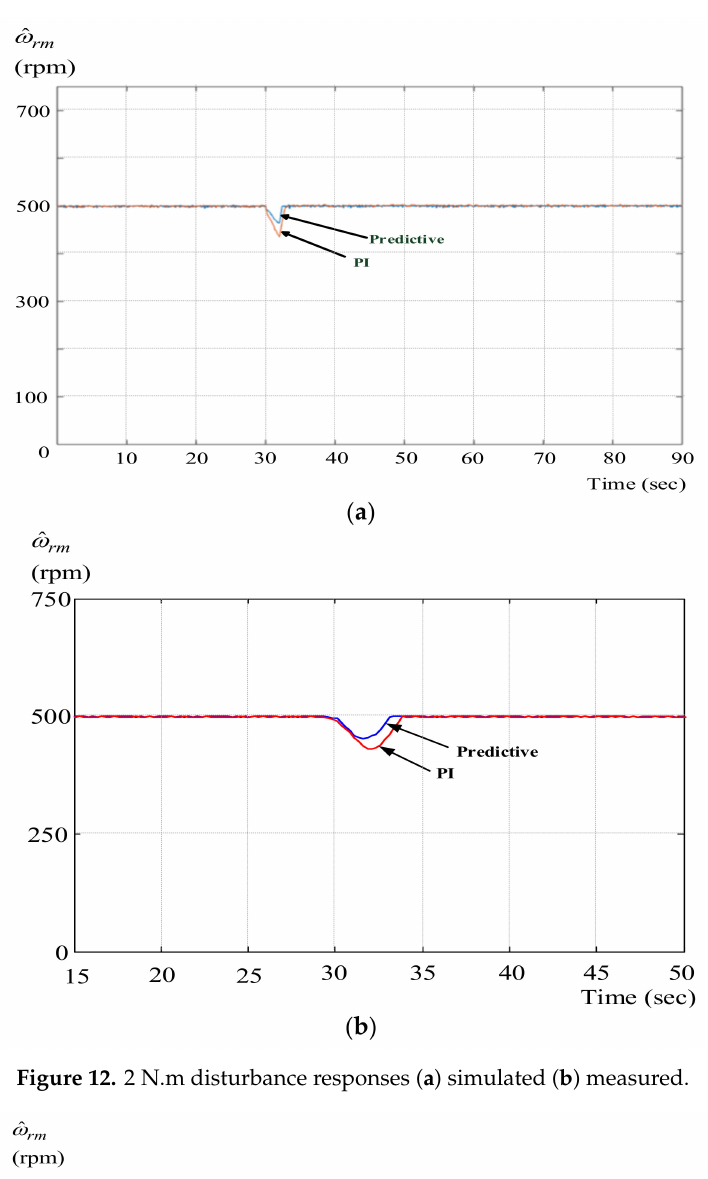
Figure 12. 2 N.m disturbance responses ( a ) simulated ( b ) measured.